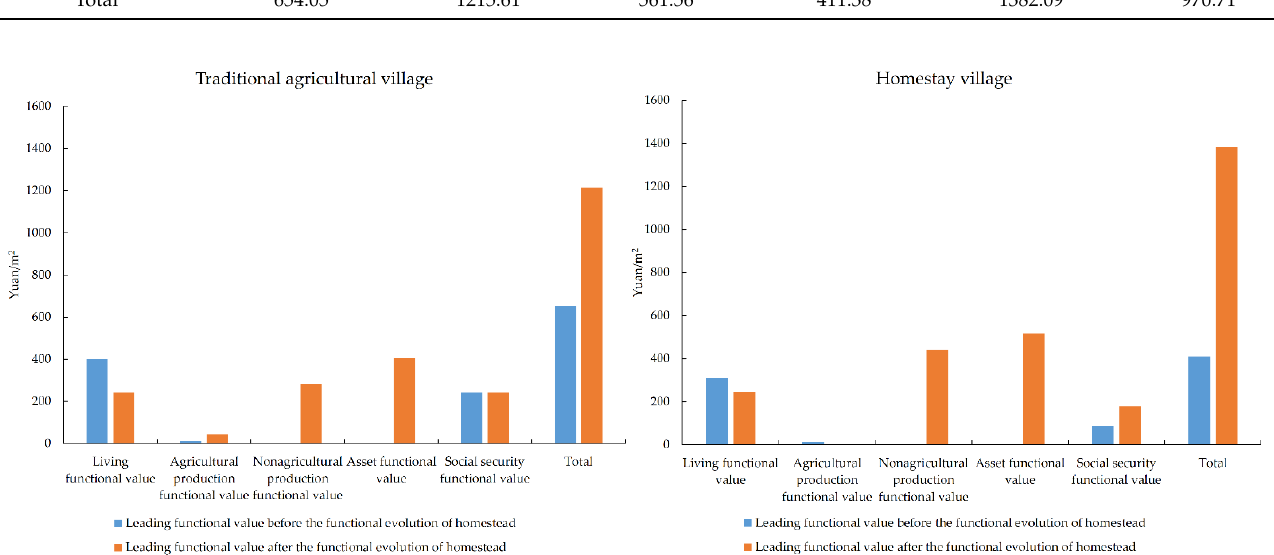
Figure 4. The functional value of homesteads in a traditional agricultural village and homestay vil- lage